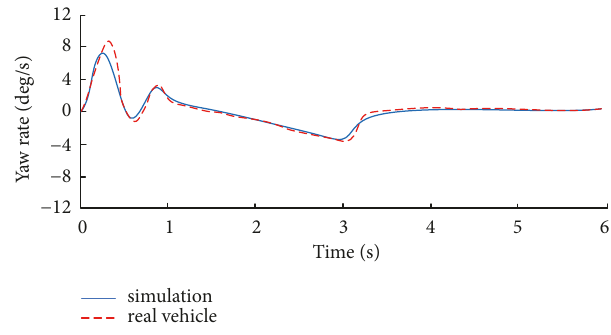
Figure 13: Vehicle yaw angular velocity